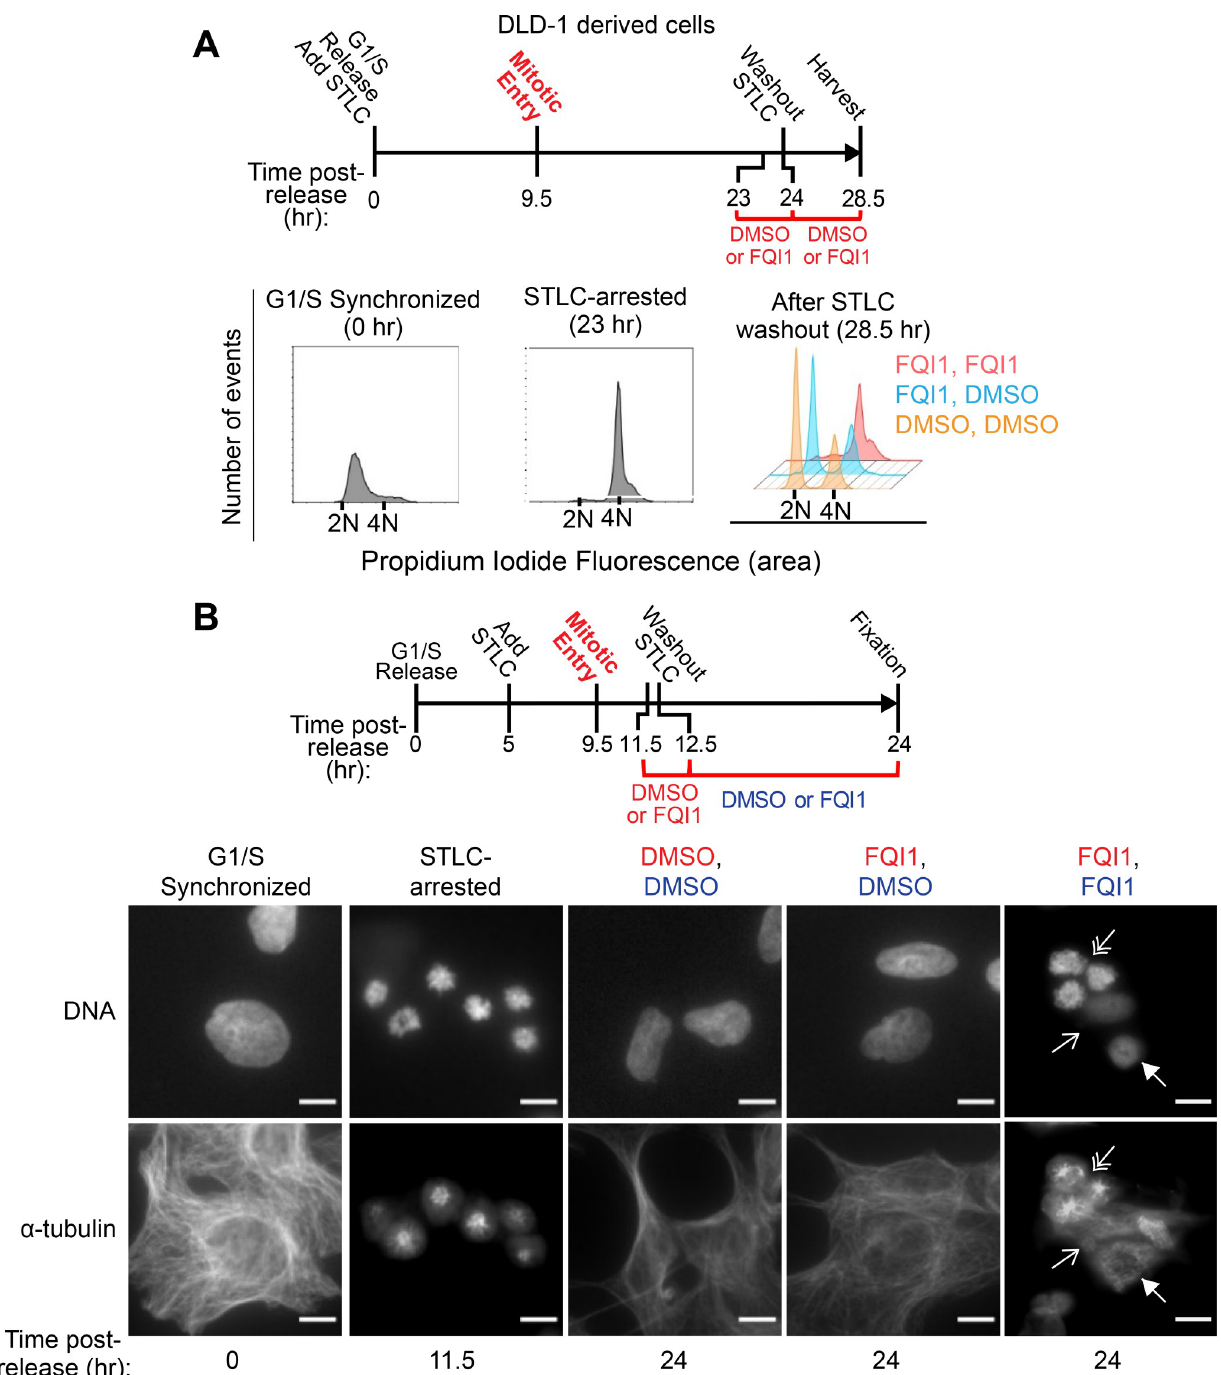
Fig 2. FQI1 addition in early mitosis is sufficient to induce rapid, reversible mitotic arrest. (A) Top: Schematic for treatments of synchronized DLD-1 derived cells following release from a single thymidine block. At the indicated time points, DNA content was profiled. At the final timepoints (28.5 hours): orange, control; blue, 4 μ M FQI1-treated for 1 hour only; red, maintained in 4 μ M FQI1. Representative of three experiments with 10,000 events analyzed for each treatment. (B) Left: Schematic for treatment of DLD-1 derived cells following release from a single thymidine block. Right: Representative immunofluorescent images of DNA and α -tubulin, harvested at the indicated times and treatment conditions. Cells mitotically arrested with STLC exhibited monopolar asters. Cells harvested at 24 h were maintained either in vehicle (DMSO) or 4 μ M FQI1 for 12.5 h, or treated with 4 μ M FQI1 for only 1 h, followed by vehicle for 11.5 h, as indicated by the color of the letters. Scale bars are 10 μ m for all images. Cells maintained in FQI1 throughout are representative of a total of 56 cells from 8 images, demonstrating multiple mitotic-related defects, including arrest in mitosis (3 cells at double arrows)